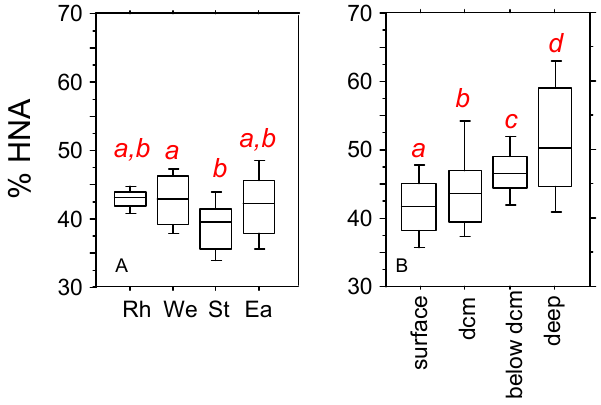
Fig. 7. Box plots showing distributions of %HNA in the different regions for the surface layers (A) and distribution of %HNA in the different layers (all stations included, (B) ). Within a common layer, groups connected by the same letter (in italics and in red) are not significantly different at the 0.01 probability